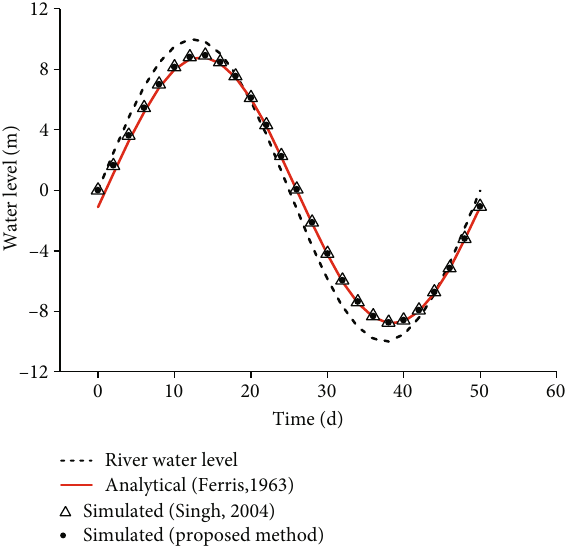
Figure 10: Variation of water level with time.